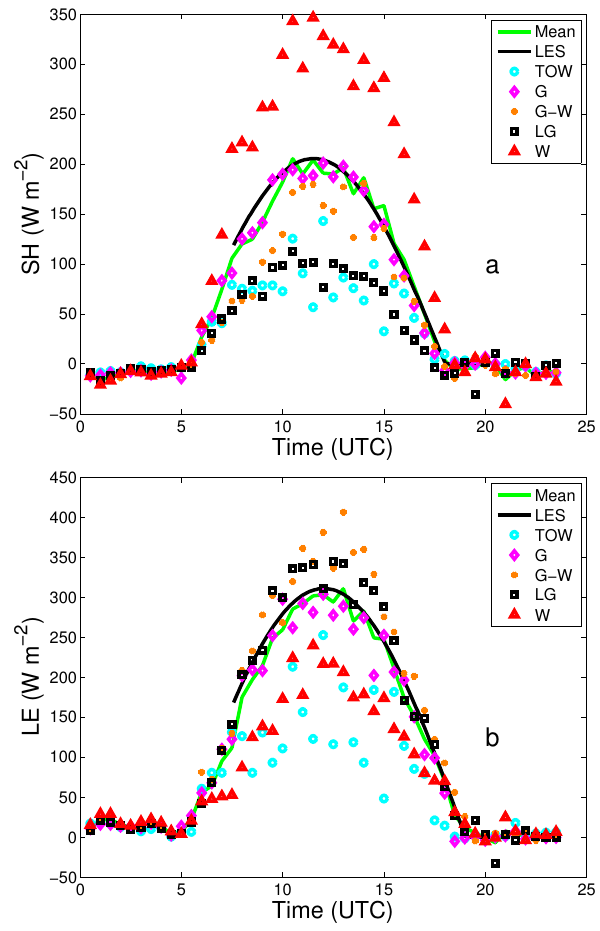
Fig. 1. Temporal evolution of (a) sensible and (b) latent heat fluxes on 1 July 2011 observed at 2 m (symbols) or 30 m in the tower case and its mean (green line), and prescribed (black line). Observations are from EC instrument at the tower over grass (TOW, cyan circles), over short grass (G, magenta diamonds), over the edge between the long grass and the wheat (G–W, orange dots), over long grass (LG, black squares) and over wheat (W, red